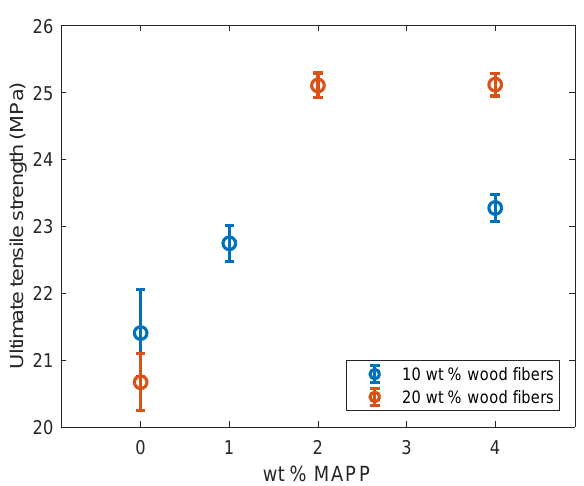
Figure 4. Ultimate tensile strength as function of MAPP percentage for 10 wt % wood fibres and 20 wt % wood fibres.